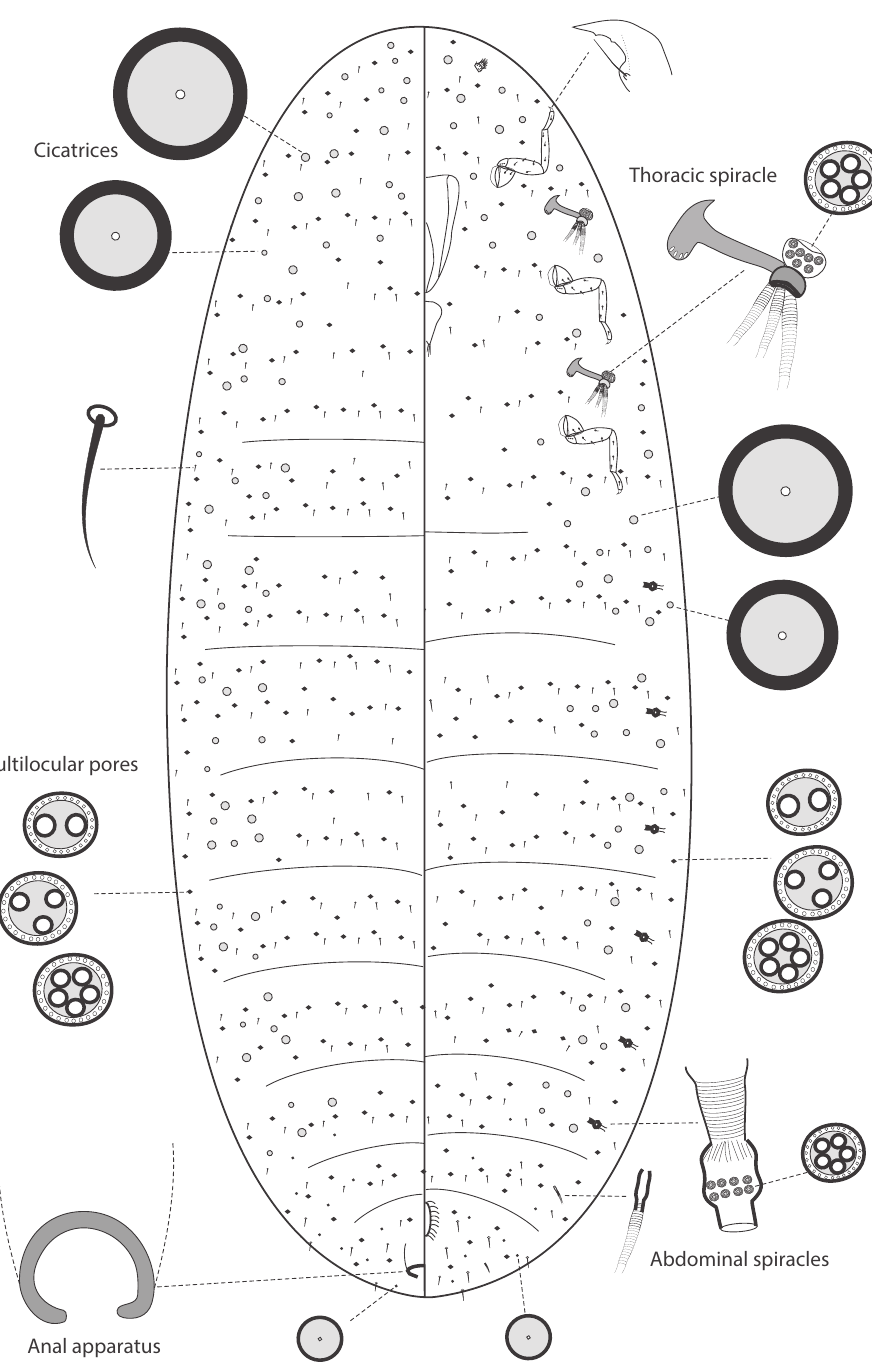
Figure 1. Morphology of adult female of Jansenus burgeri Foldi, 1997, Laos (Pak